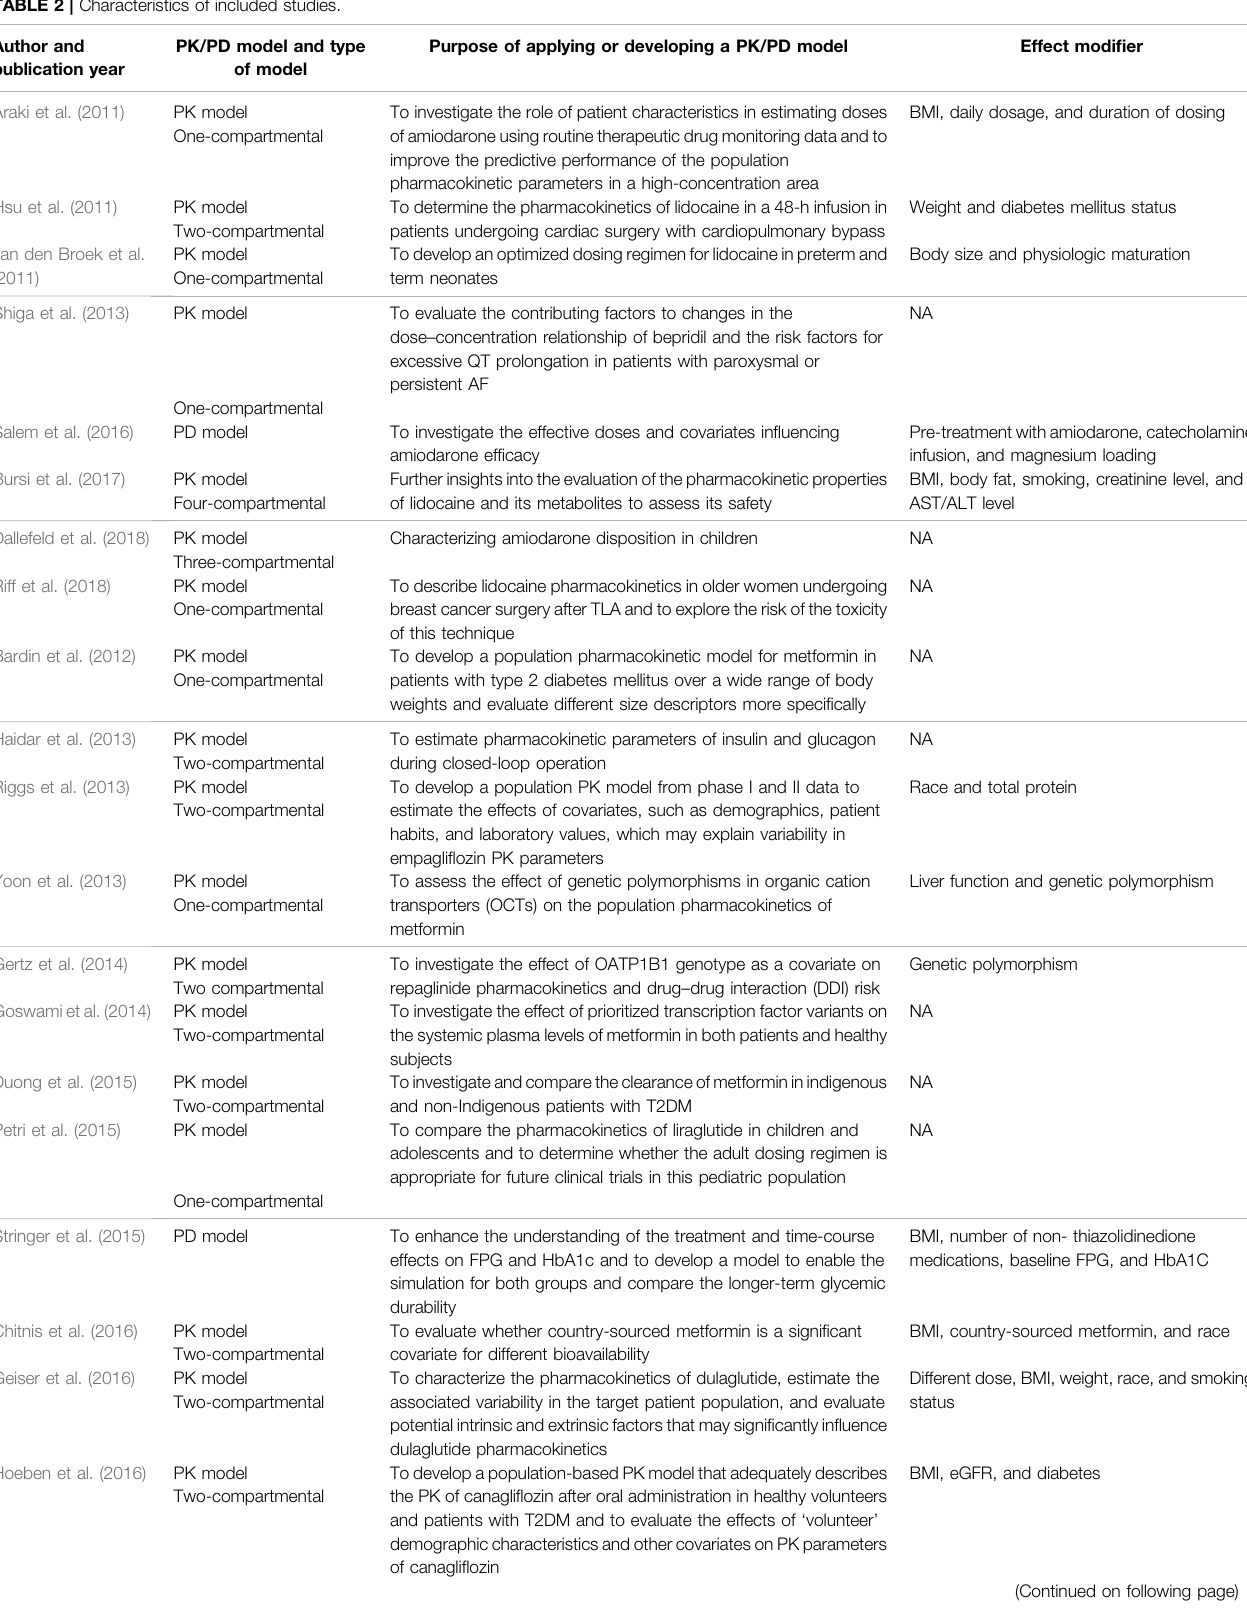
TABLE 2 | Characteristics of included